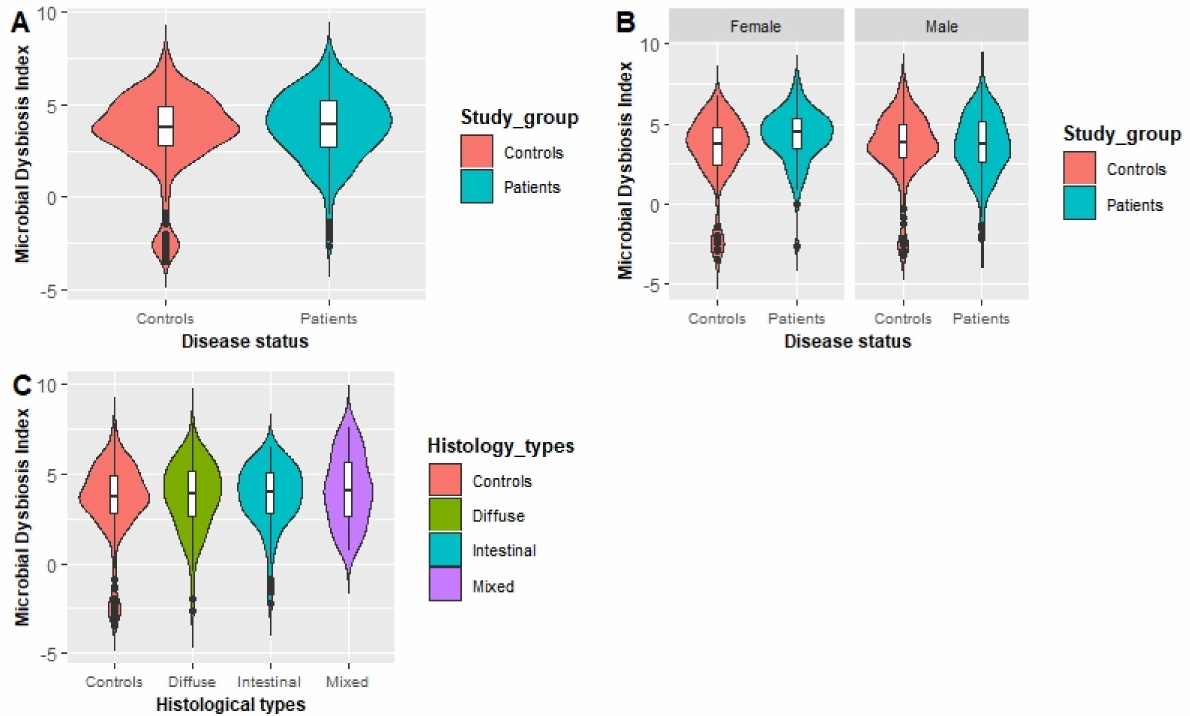
Figure 4. ( A ) Comparison of the MDI between patients and controls in the total population. ( B ) Comparison of the MDI between patients and controls in male and female populations. ( C ) Comparison of the MDI between patients with different histological types of GC and controls. GC, gastric cancer; MDI, microbial dysbiosis